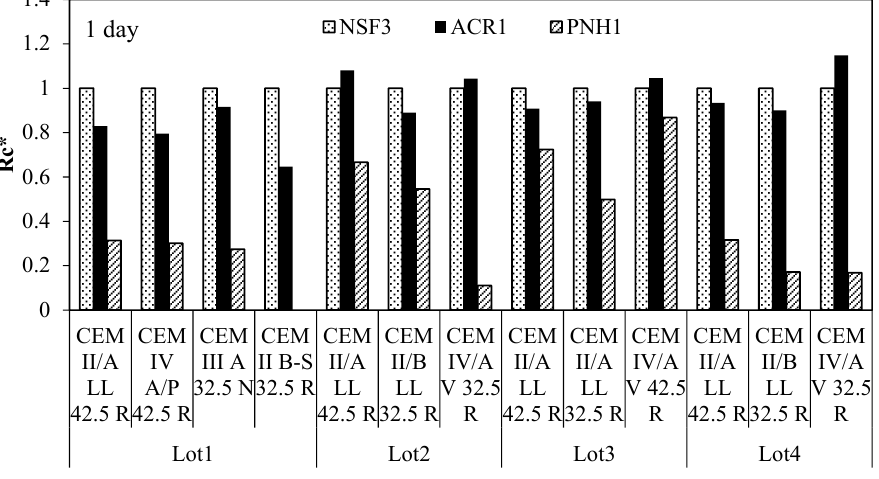
Figure 8. Normalized compressive strength at 1 day.